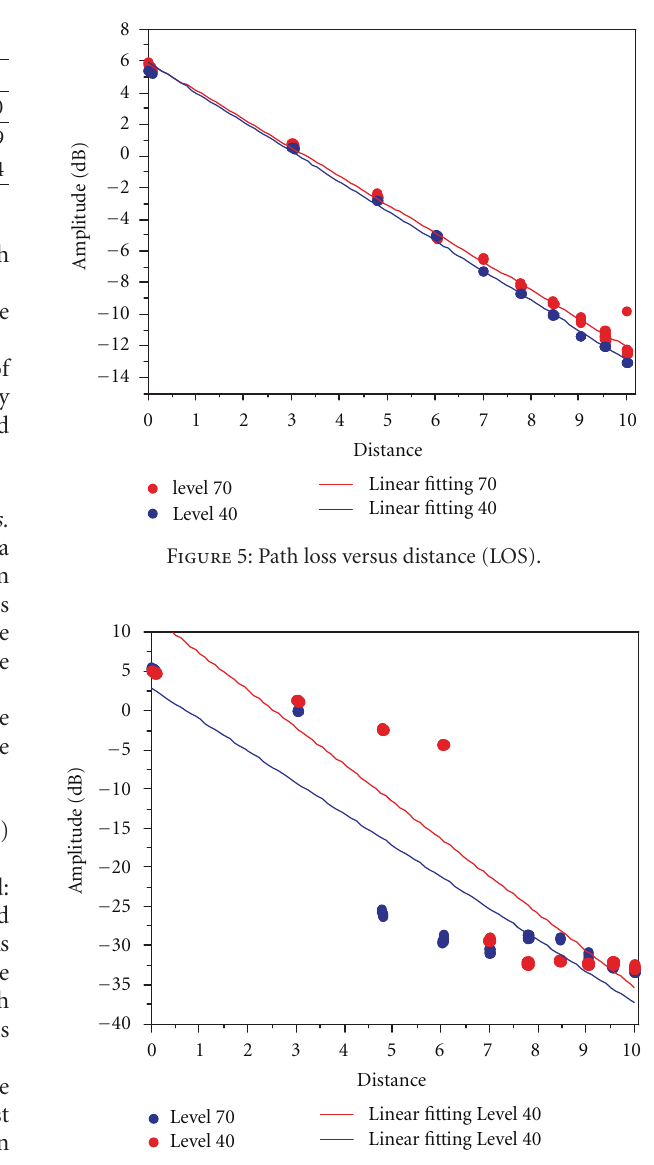
Figure 6: Path loss versus distance (NLOS). Table 2: Path loss exponents and Standards deviations in LOS case.